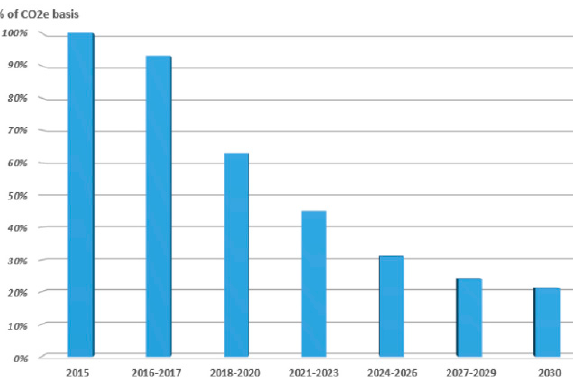
Figure 4. Hydrofluorocarbon (HFC) phase-down schedule (Co2e %) [9].